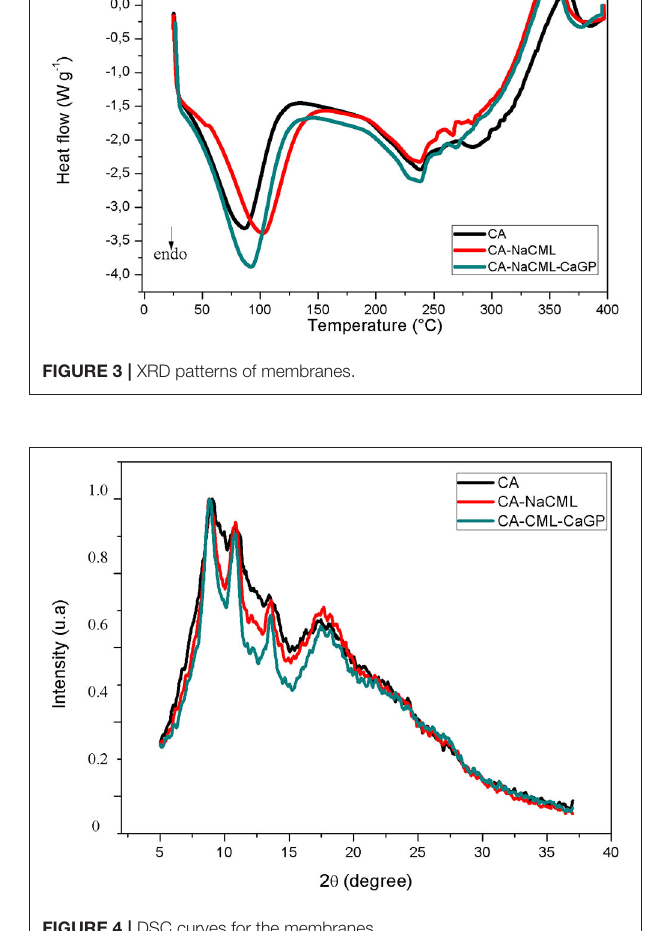
FIGURE 4 | DSC curves for the membranes.